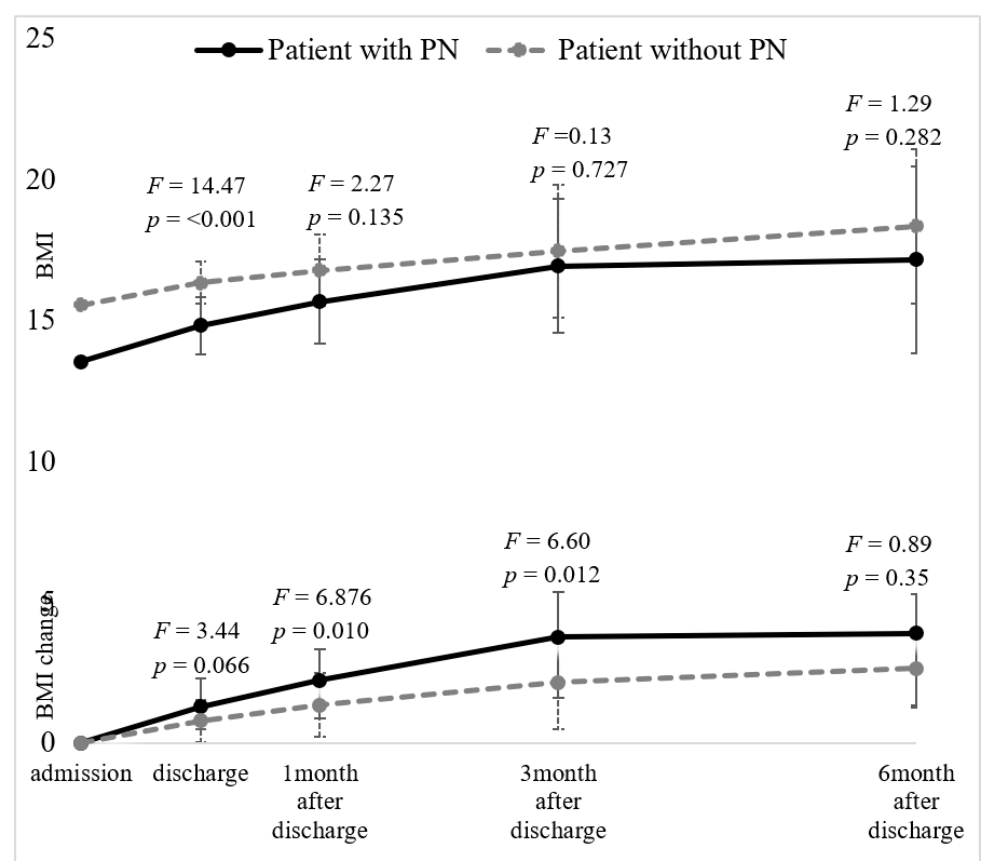
Figure 2. The comparisons of BMI and the BMI change controlled for the effect of AN subtypes between the patients with PN and the patients without PN at discharge and 1, 3 and 6 months after discharge. The bars indicate the mean ± standard error at each time point. Abbreviations: BMI, body mass index; PN, parenteral